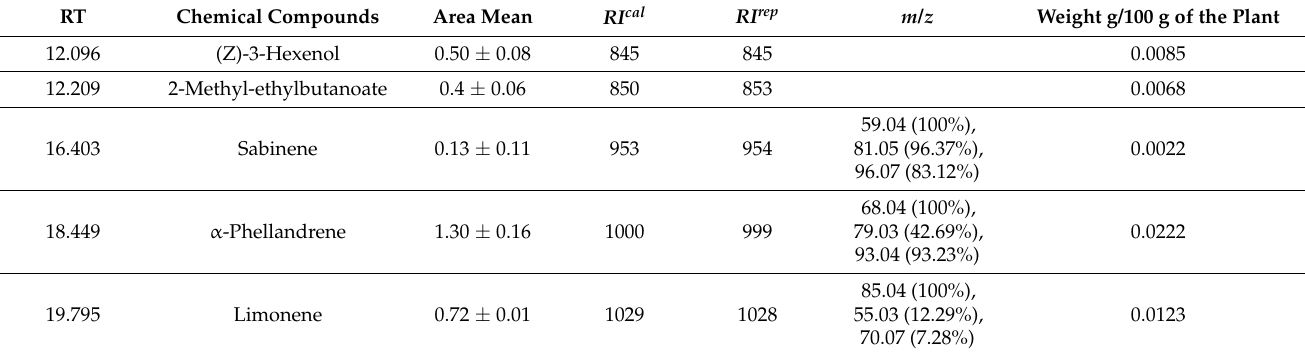
Table 2. Essential oil constituents of A. judaica growing in the Northern Qassim region of Saudi